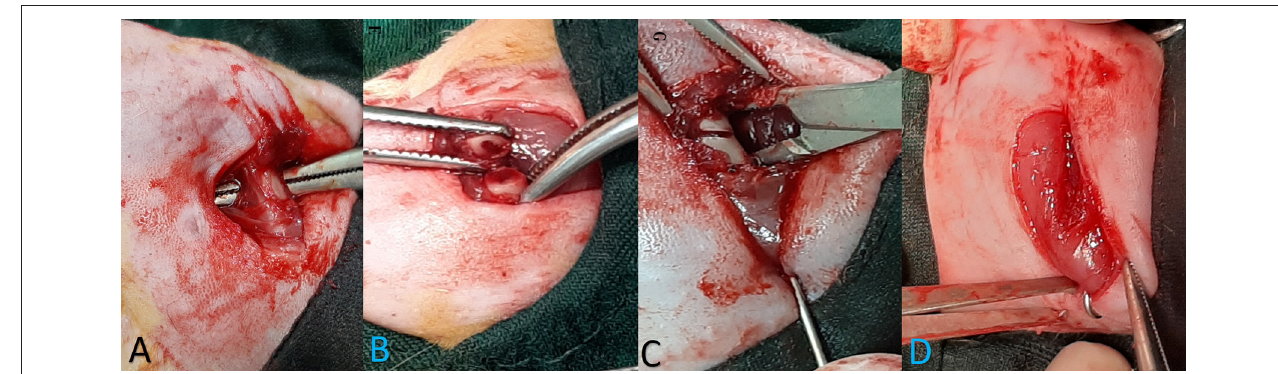
FIGURE 2 | The stages of bone fracture. (A) Anesthesia induction was done by the injection of ketamine and xylazine and the maintenance of anesthesia during surgery with 1% isoflurane. (A) A lateral incision of the thigh was done and, through intermuscular plan femoral bone, has been exposed. (B) Osteotomy site. Osteotomy was performed with an orthopedic saw. Injected saline was used during the incision to prevent heat damage, and the cut was made completely transversely. (C) Retrogradely, the pin was inserted in the proximal part and exited from the greater trochanter; then, the reduction was established, and the pin was inserted and continued from the greater trochanter to the distal part of the femur. (D) Reduction was controlled visually and by radiography, then a pin was cut and buried under the muscles around the greater trochanter, and wound suturing was performed in anatomical layers.